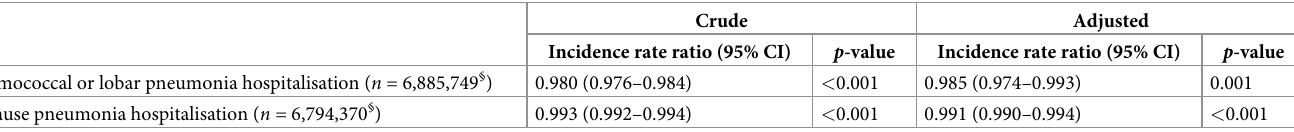
Table 6. Crude and adjusted � incidence rate ratios of pneumonia hospitalisations among undervaccinated children under 5 years, by percent increase in PCV cover- age † among children under 5 years of age, New South Wales and Western Australia, 2009–2012.